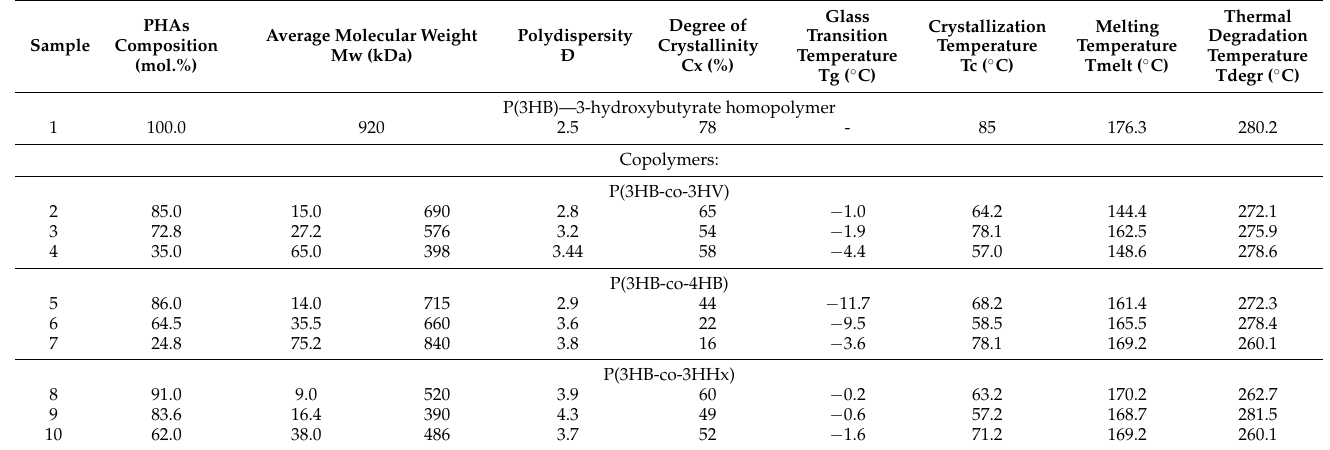
Table 1. Characterization of PHAs different